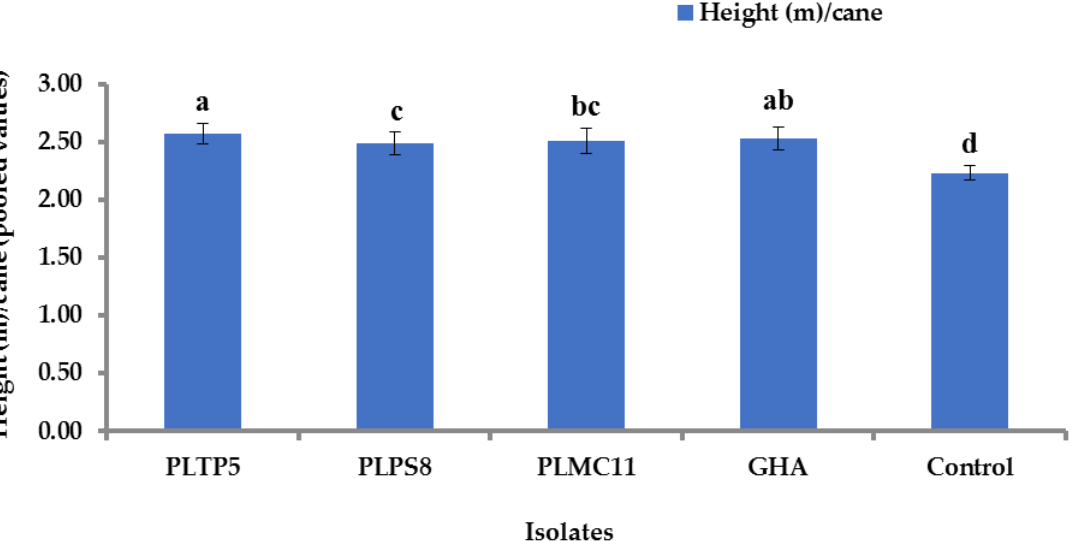
Figure 11. Effect of EPF conidia formulation application on the height of sugarcane. Different letters (a–d) in columns indicate significant differences ( p ≤ 0.05) among the isolates. Columns represent the mean ± SD ( n = 3). SD = standard deviation.